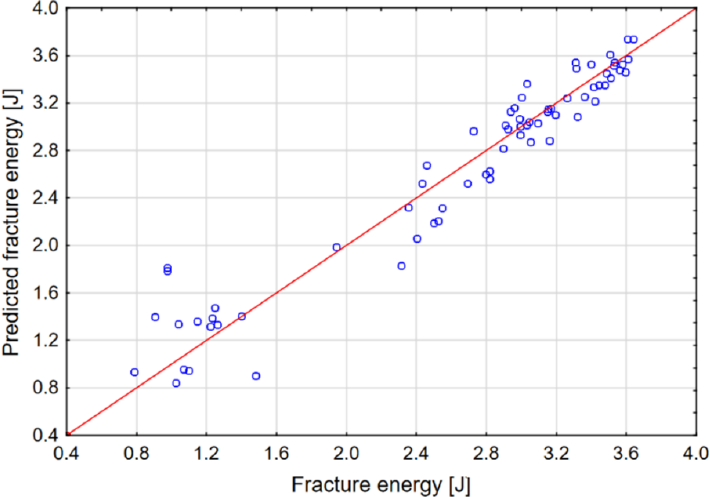
Figure 10. Actual versus predicted values: maximum force.